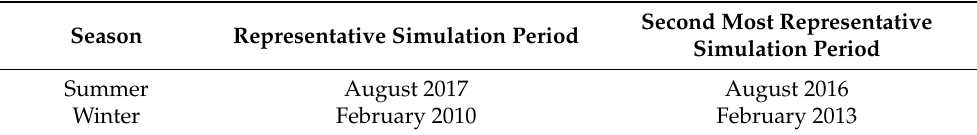
Table 2. Simulation period employed to develop hydrodynamic models for summer (characterised by low river discharge) and winter (characterised by high river discharge).